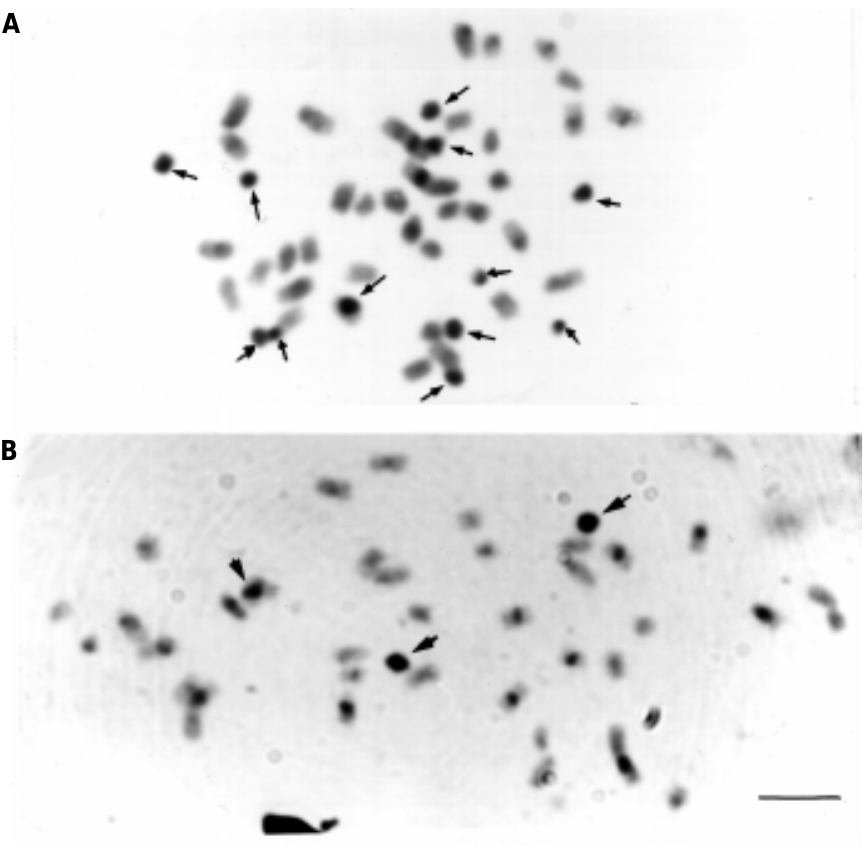
Figure 5 - C-banding pattern of two cytotypes of Mikania micrantha. A. Population from Piracicaba, B. Population from Campinas. Bar = 5 m m. Arrows indicate some of the heterochromatic